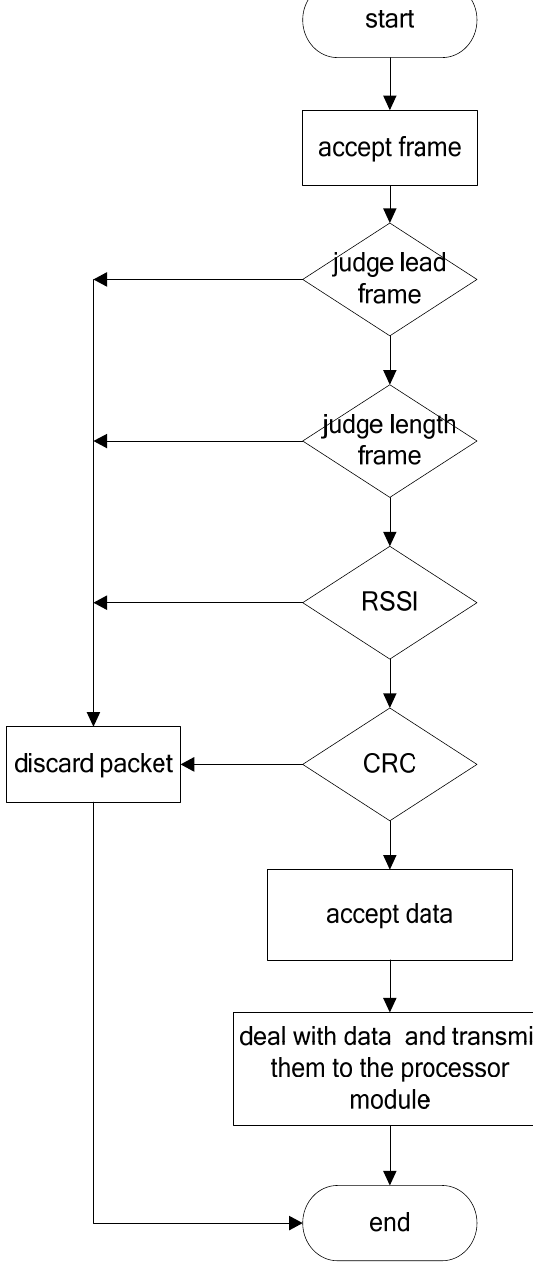
Figure 9. The flow diagram of the CC2420 accept